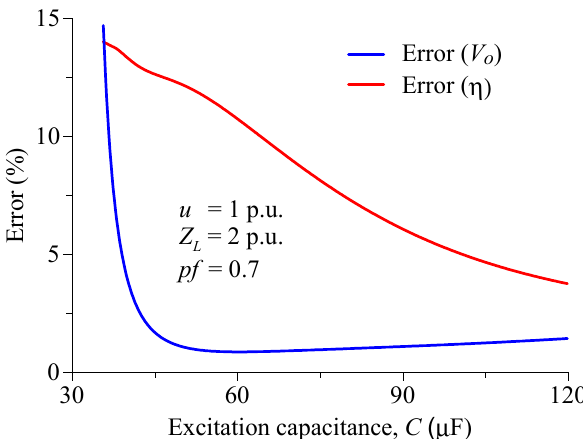
Figure 16. Error variation of terminal voltage V o and efficiency η versus excitation capacitance C .